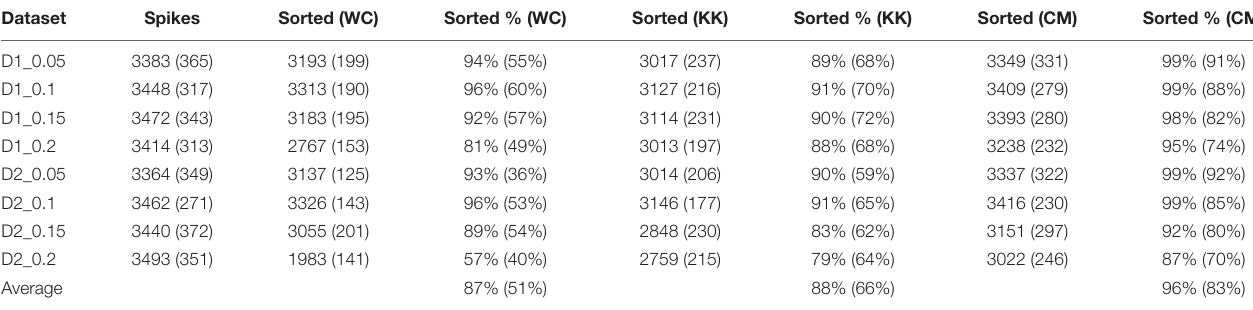
TABLE 1 | The results of applying Wave_clus (WC), KlustaKwik (KK), and our method (CM: current method) to simulated data from Quiroga et al. (2004). Dataset Spikes Sorted (WC) Sorted % (WC) Sorted (KK) Sorted % (KK) Sorted (CM) Sorted % (CM)